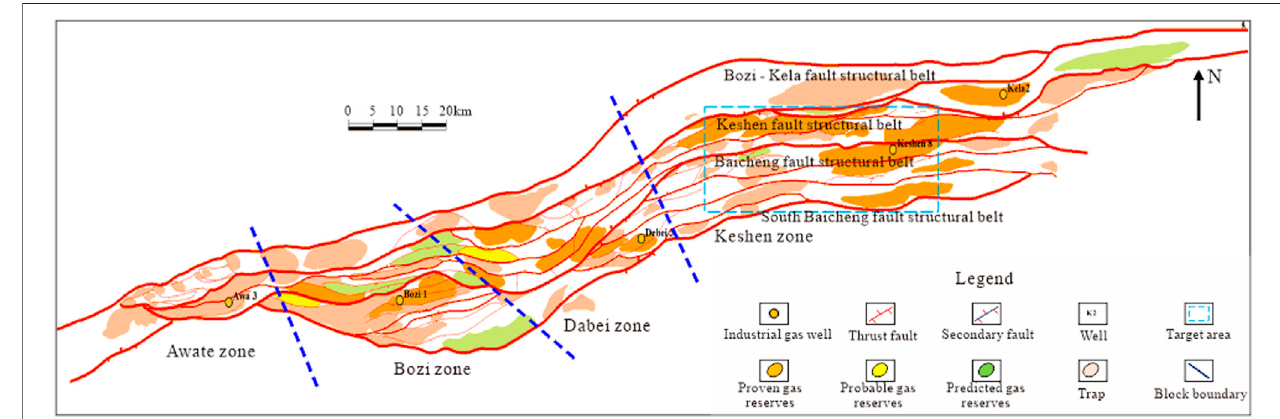
FIGURE 1 | Location of the target area Keshen gas fi eld.